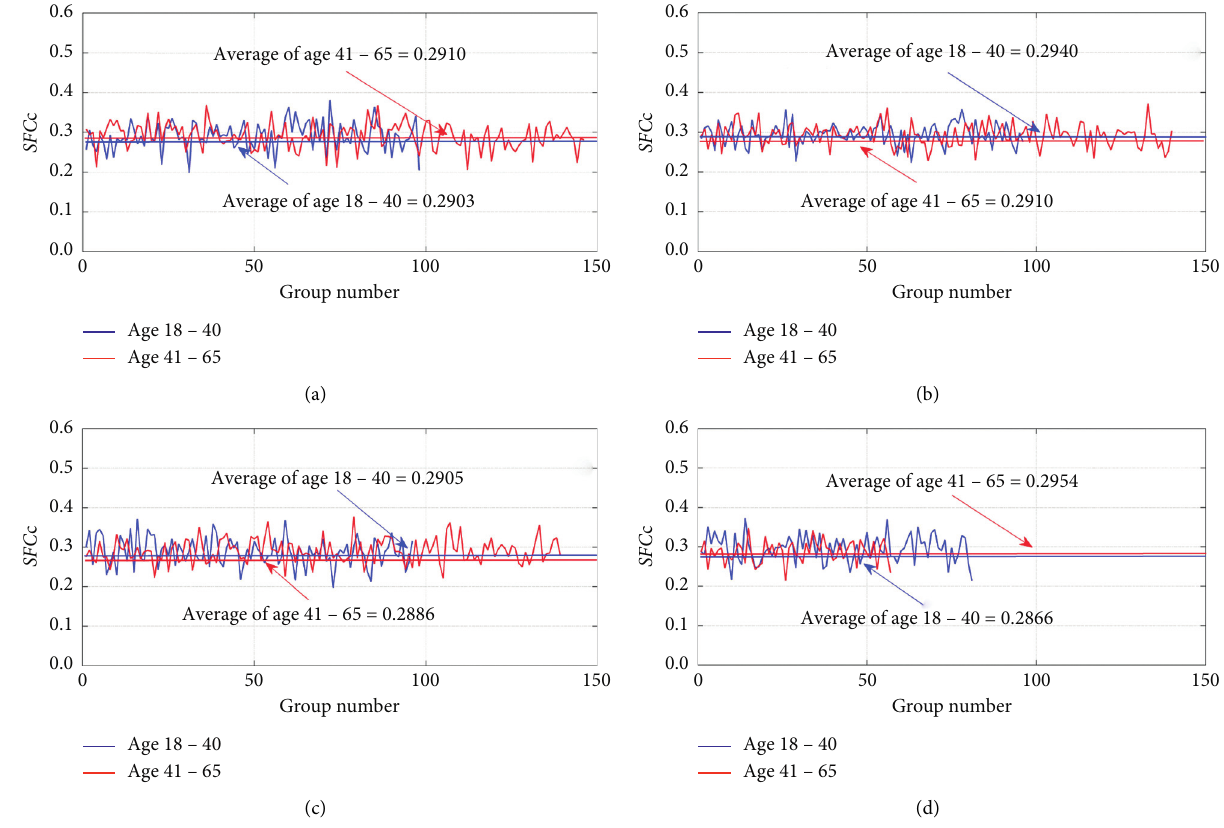
Figure 6: The SFC c of different age group. (a) Section 2. (b) Section 3. (c) Section 4. (d) Section